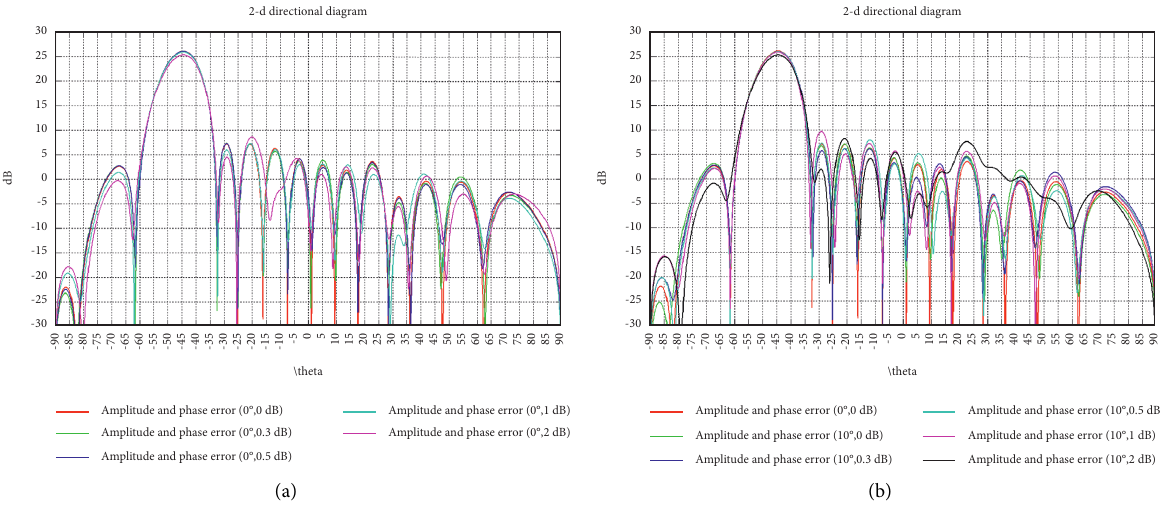
Figure 4: Random amplitude and phase antenna scanning − 45 ° pattern simulation results: (a) phase is 0 ° ; (b) phase is 10 ° .